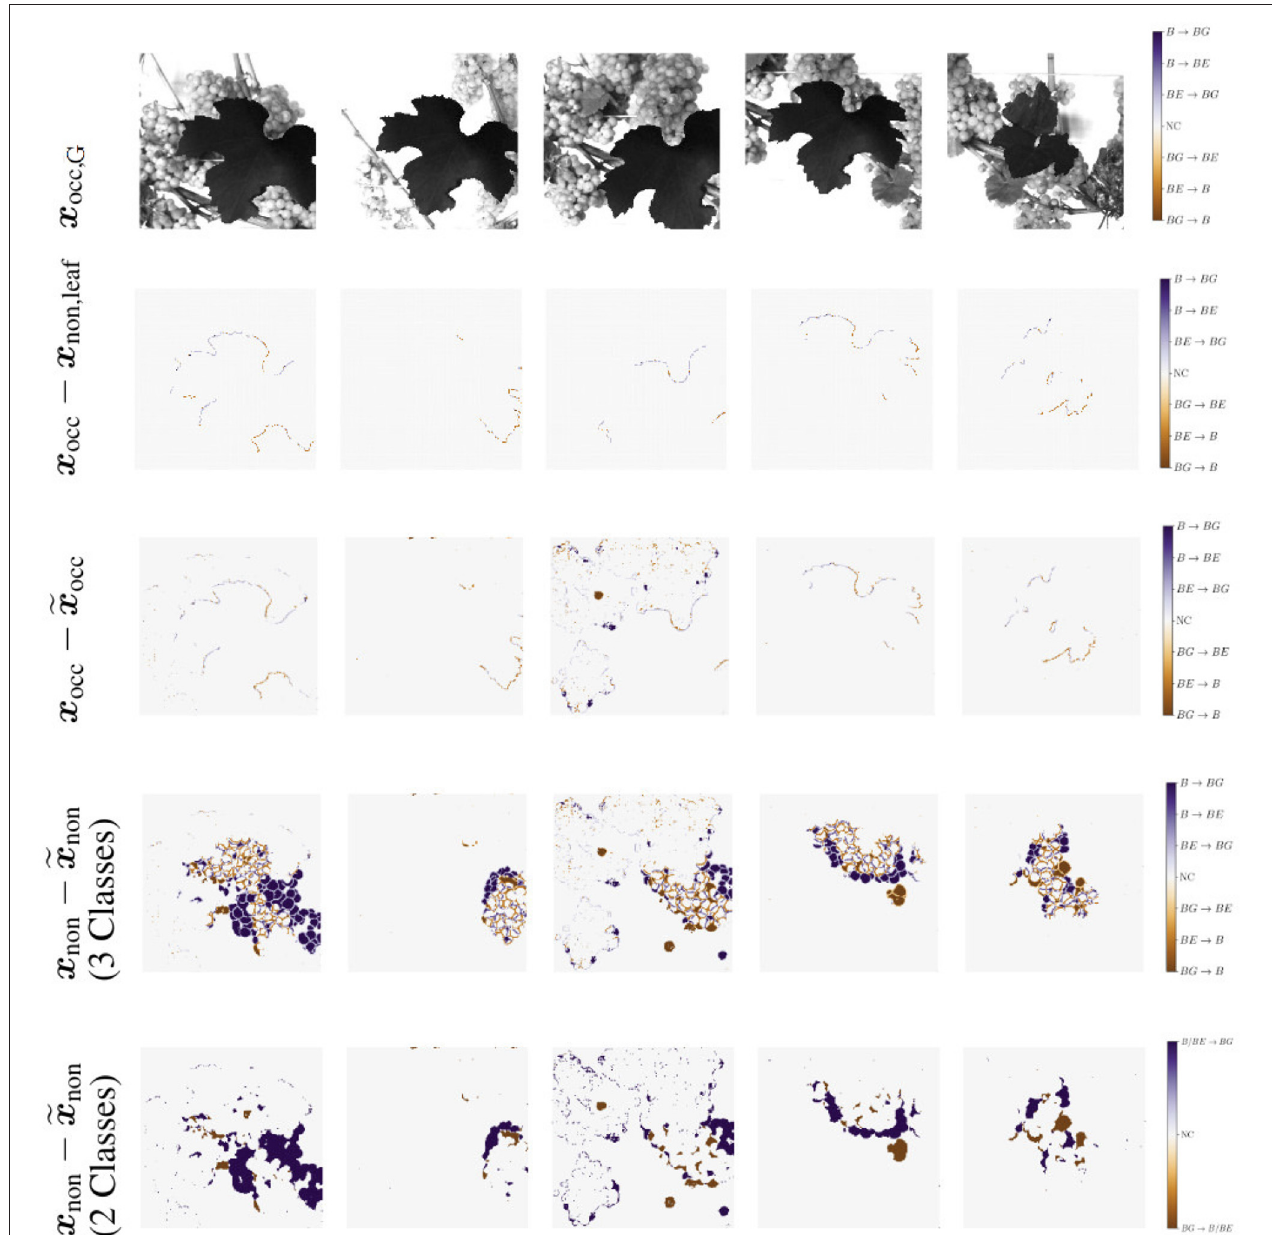
FIGURE 11 | Generation maps between target berry masks and generated output berry masks, as described in Section 3.4.2. The first row illustrates the respective grayscale input image. The second row shows the input x occ compared to the target output occluded by the leaf used for creating the input x non,leaf . The third row shows the maps in the occluded domain. The input x occ is compared to the generated output occluded by the leaf used for creating the input row occur in the occluded domain. The fourth and fifth row show the maps of the non-occluded domain. The target output x non is compared to the generated output x non . In the fourth row all three classes are included. The last row illustrate the same, but including only two classes. Classes berry-edge BE and berry B are e combined in one class. Background is indicated by BG and if there is no class change it is indicated by NC for no change.